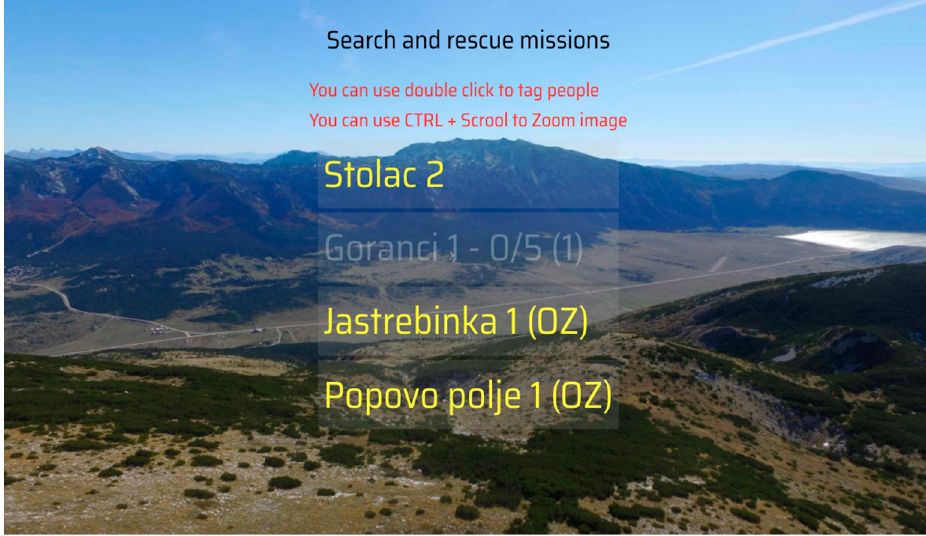
Figure 8. List of missions of the developed web application for detection accuracy comparison between the expert and the ScoreMap to ROI algorithm.